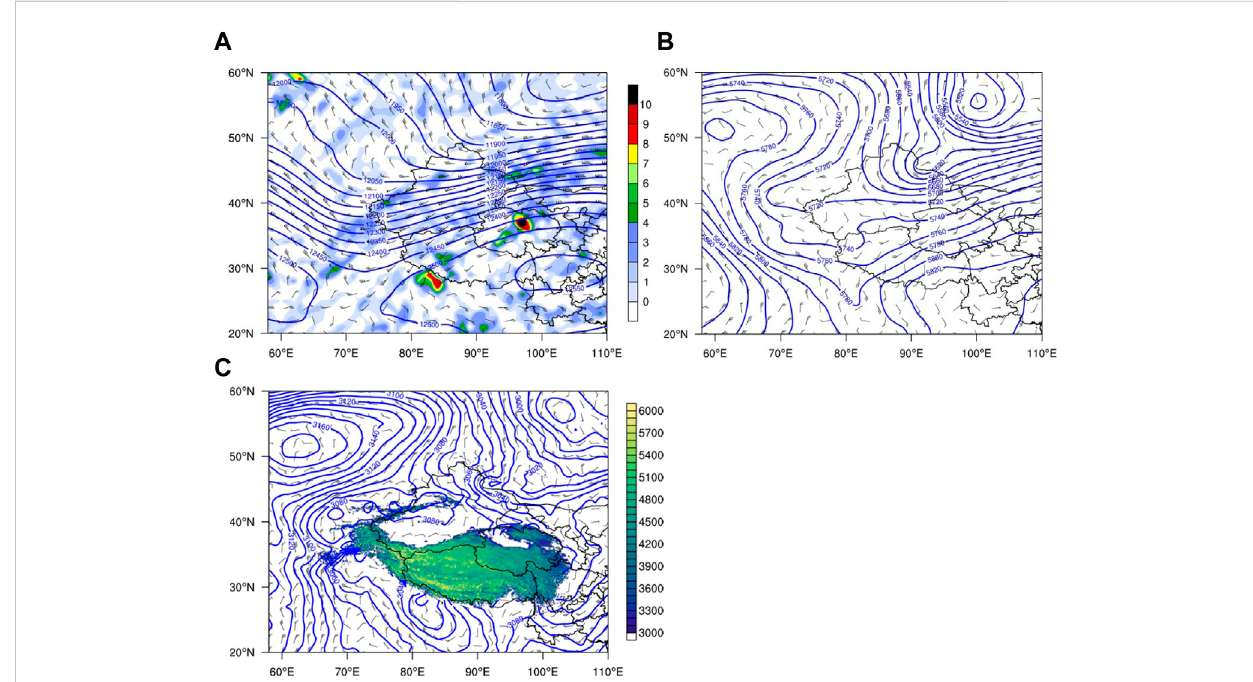
FIGURE 2 (A) Horizontal divergence (shadings, units: 10 – 5 s -1 ), geopotential heights (blue contours, units: gpm) and wind fi elds (wind barbs, units: m s − 1 ) at 200 hPa, and geopotential heights (blue contours, units: gpm) and wind fi elds (wind barbs, units: m s − 1 ) at (B) 500 hPa and (C) 700 hPa at 0000 UTC on 15 June 2021. In Fig. c, the shaded areas denote the topographical height (units: